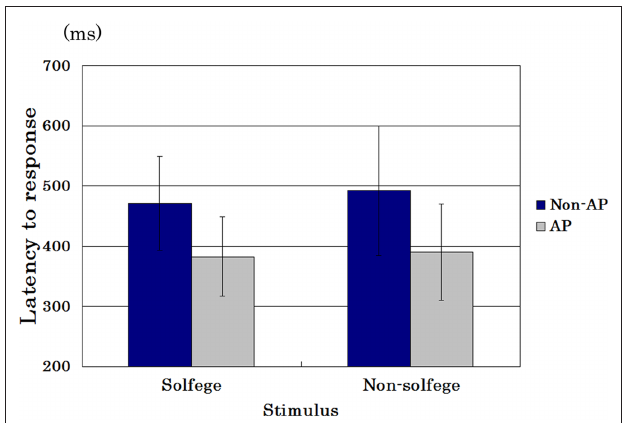
Figure 1 | Mean latency (error bars: SDs) of AP possessors and of non-AP possessors in the identification session to press the button when the presented stimuli were solfege syllables as well as non-solfege syllables.